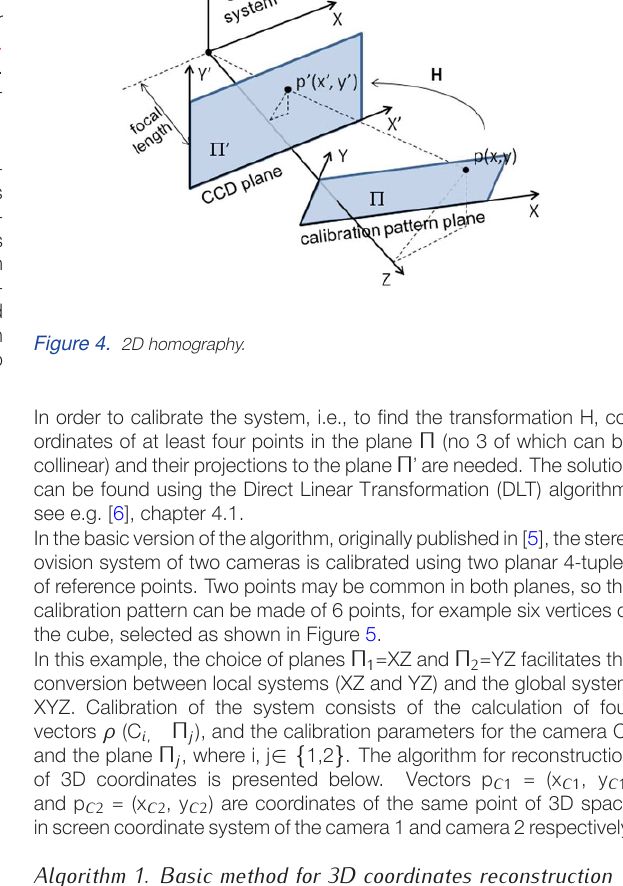
Figure 3. In our method location of the reference points at planes